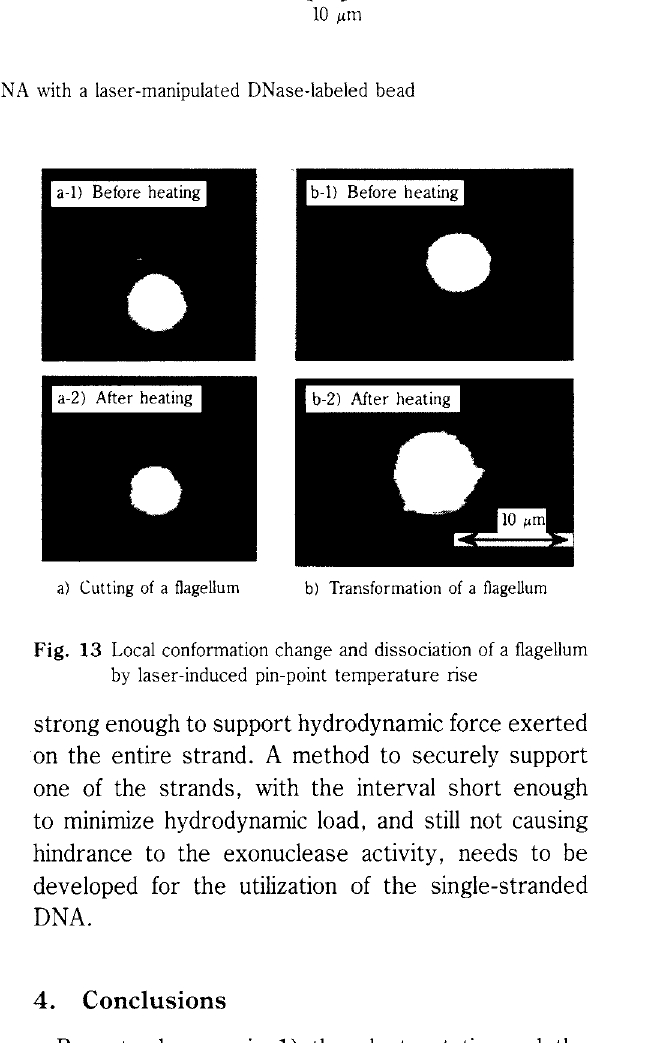
Fig. 12 Cutting of the stretch-and-positioned DNA with a laser-manipulated DNase-labeled bead